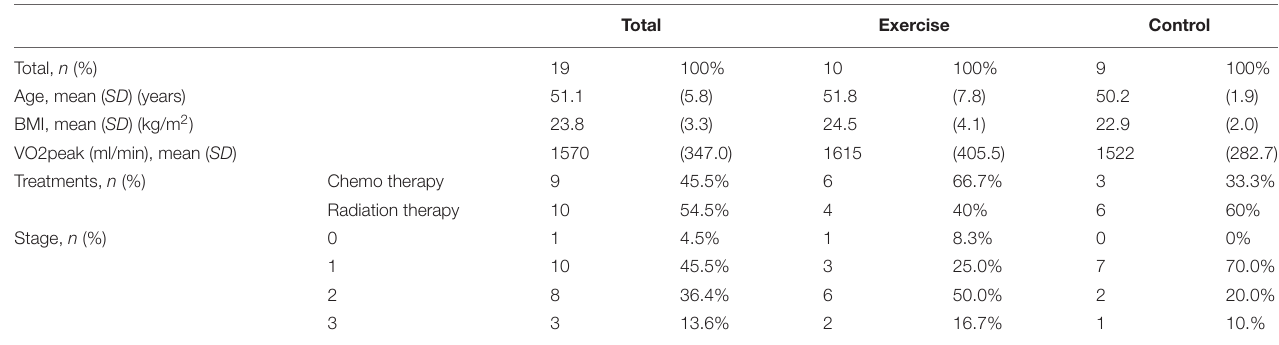
TABLE 1 | Participant